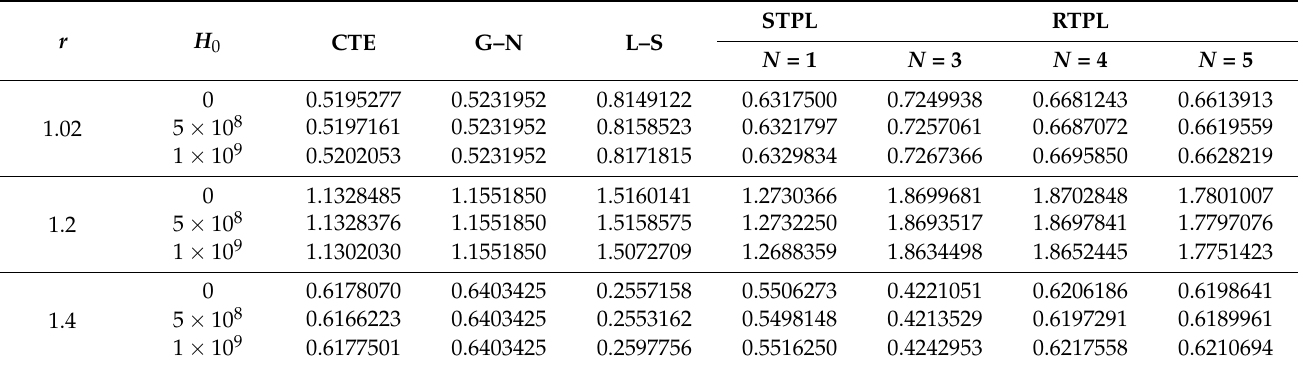
Table 8. Different thermoelasticity theories with a range of r values show the effects of dimensionless magnetic field intensity H 0 on temperature Θ .